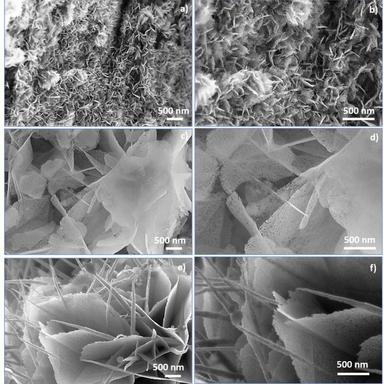
SEM images taken at different magnifications of the catalysts after their growth on PGR: a) and b) NiOeP, c) and d) Co3O4eP and e) and f) NiCo2O4eP (P stands for PGR).